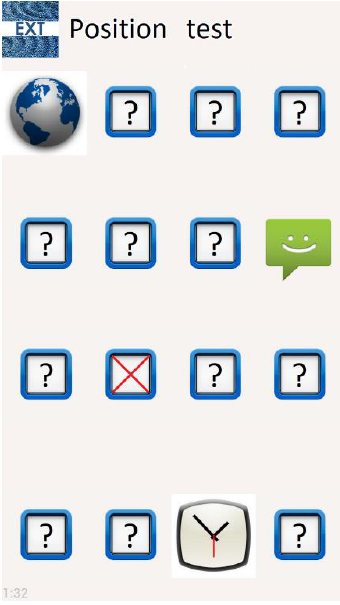
Figure 4. Test section screen. The visible icons have been correctly recognized and the “?” icons hide the haptic icons to be recognized. The numbers on the bottom-left corner measure the time taken to make the test.